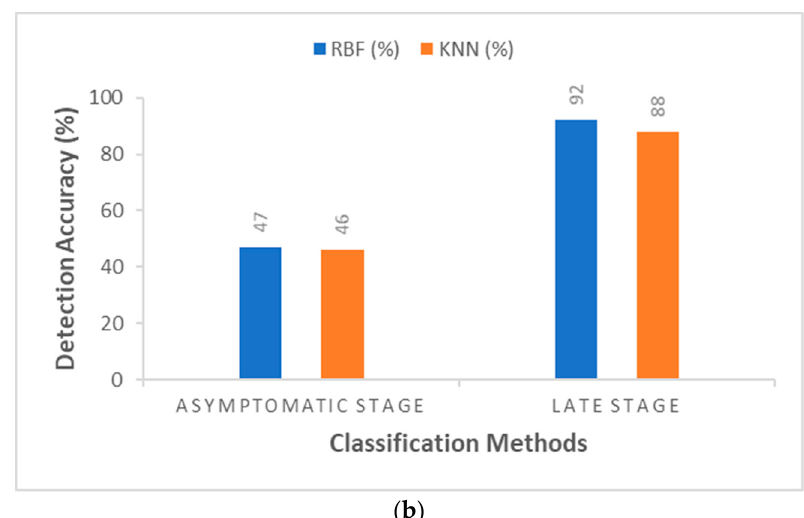
Figure 6. The classification rates of healthy and canker-infected citrus tissues (leaves and fruits) determined by the hyperspectral classification methods (radial basis function, RBF; and K-nearest neighbor, KNN) between different canker disease stages (healthy, asymptomatic, early, and late stage) for ( a ) leaves (indoor and outdoor) and ( b ) immature (green) fruits (indoor).